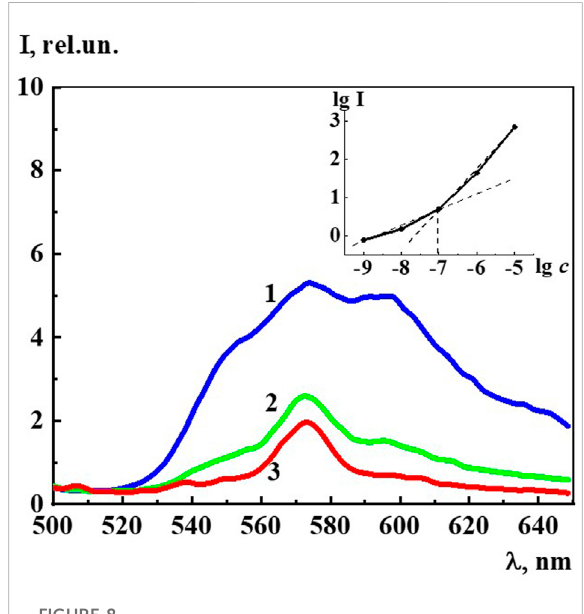
FIGURE 8 The fl uorescence spectra ( λ ex 480 nm) of the Dox systems at